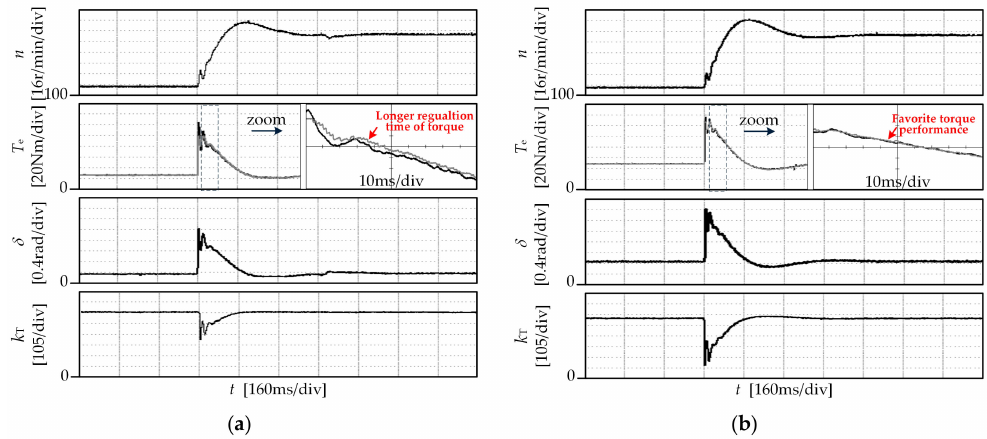
Figure 13. Experimental waveforms of the conventional DTC-SVM scheme during transient operation at K p = 2.0 × 10 − 4 ; T i = 20 T s . ( a ) No load; ( b ) 50 Nm